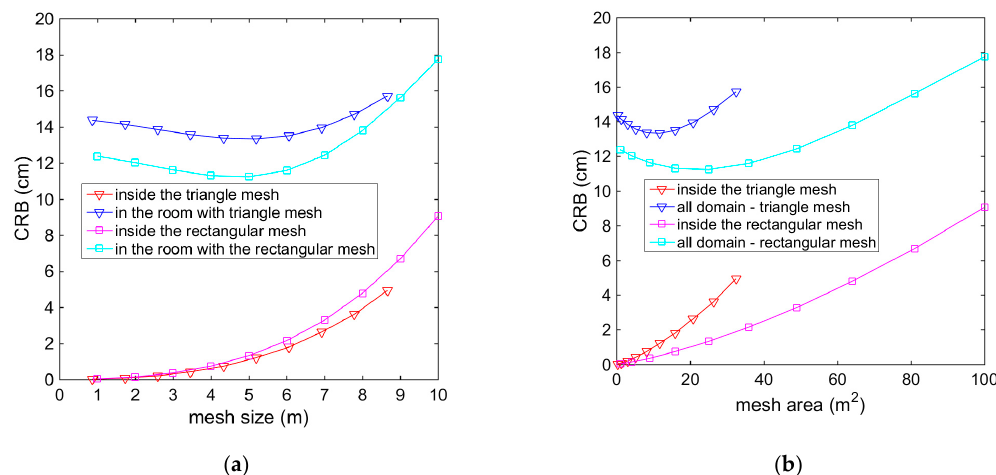
Figure 8. Calculation of the average CRB for different mesh shapes and corresponding sizes, as a function of ( a ) the mesh edge size, and ( b ) the mesh area; σ 2 = 1.